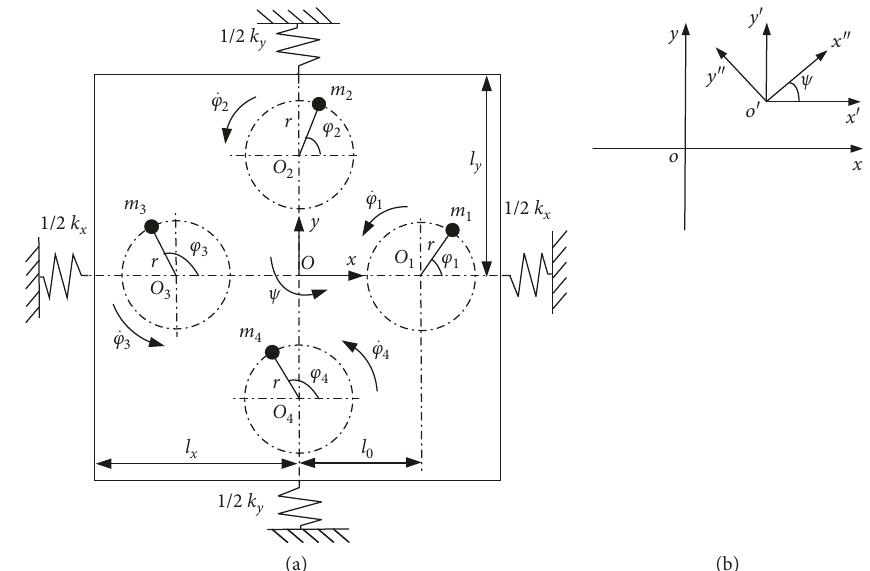
Figure 1: Model and coordinate systems. (a) Dynamic model of the vibrating system; (b) three reference coordinate